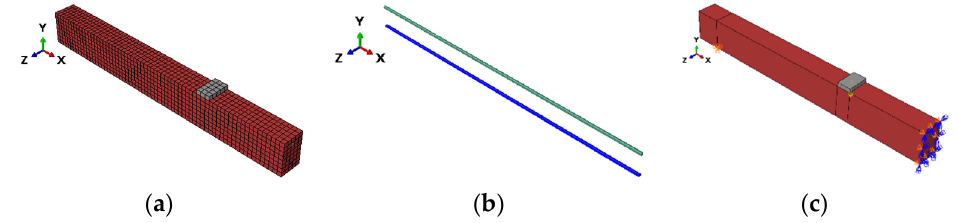
Figure 2. Representation of the: ( a ) model configuration; ( b ) control (prescribed displacements); and ( c )